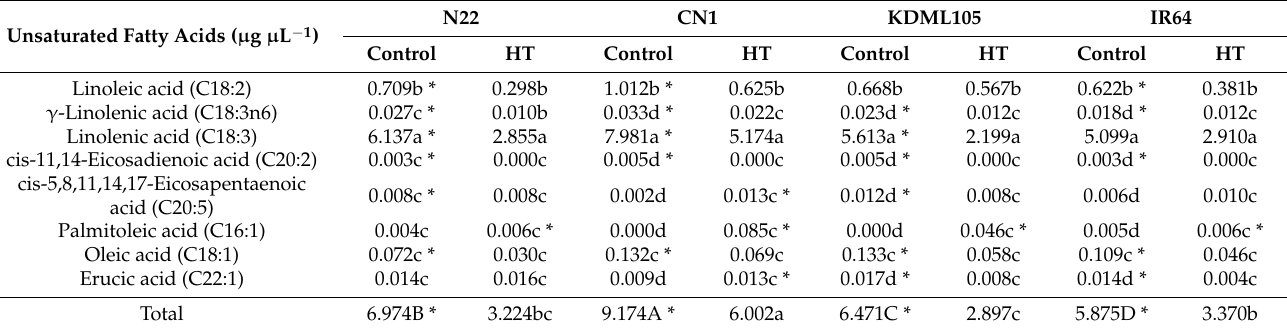
Asterisk (*) indicates significant difference between control and HT in each rice cultivar at p ≤ 0.05 by t test. Different capital letters indicate significant difference of control group in different rice cultivars at p ≤ 0.05 by ANOVA and DMRT, and small letters indicate significant difference of HT in different rice cultivars at p ≤ 0.05 by ANOVA and DMRT. Superscript small letters in the same column indicate significant difference between different unsaturated fatty acid at p < 0.05 by ANOVA and DMRT.